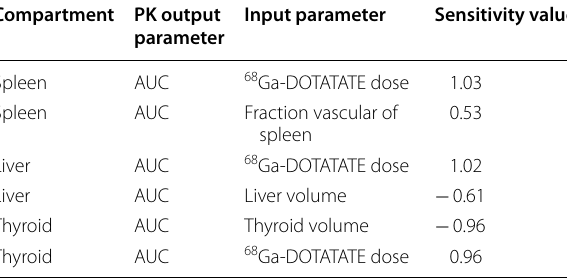
Table 3 Sensitivity analysis results for the PK output parameter area under the concentration–time curve. Only sensitivity values < 0.5 or > 0.5 were reported −